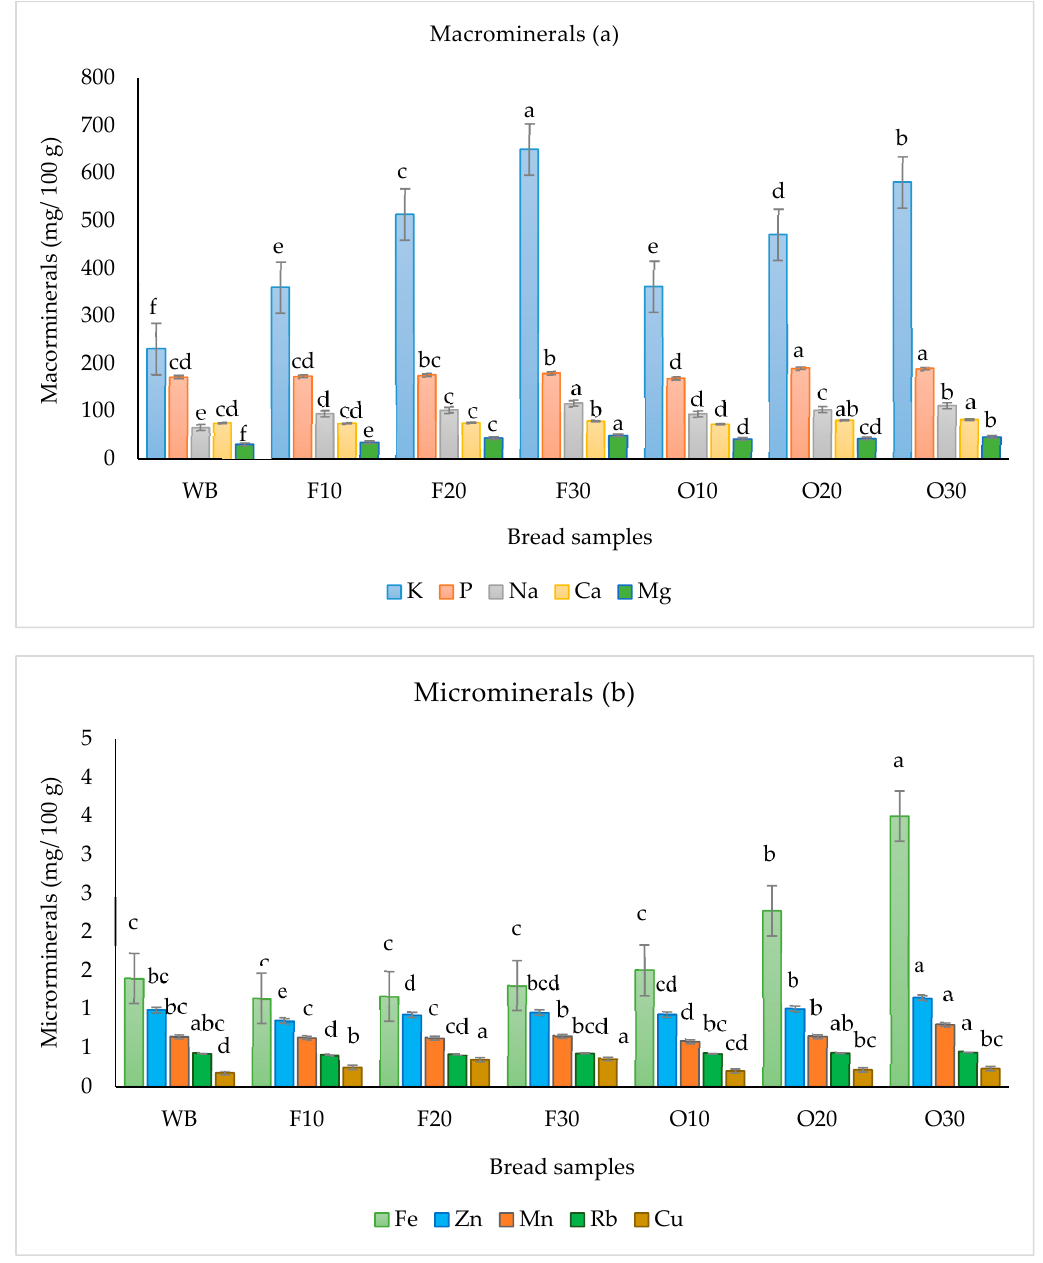
Figure 1. ( a ) Macro minerals in bread sample ( b ) Microminerals in bread samples. Bars for each mineral that have different letters are significantly different ( p < 0.05).